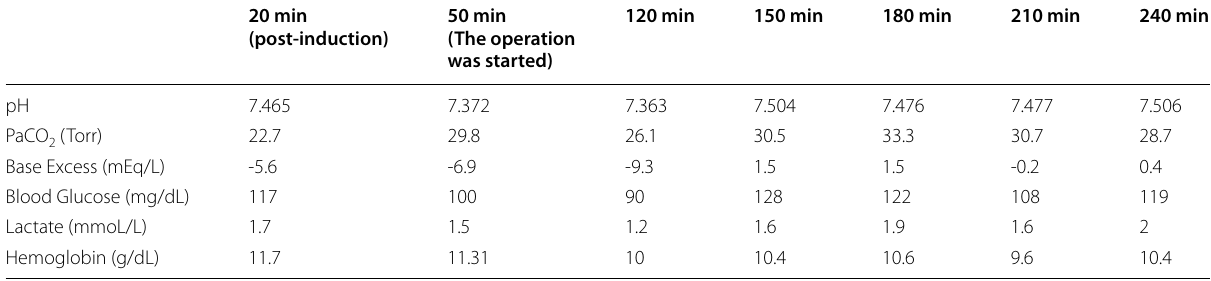
Table 1 Blood gas data. During anesthesia, metabolic acidosis gradually progressed and was improved by the administration of sodium bicarbonate. Lactic acid and blood glucose levels did not significantly fluctuate 20 min